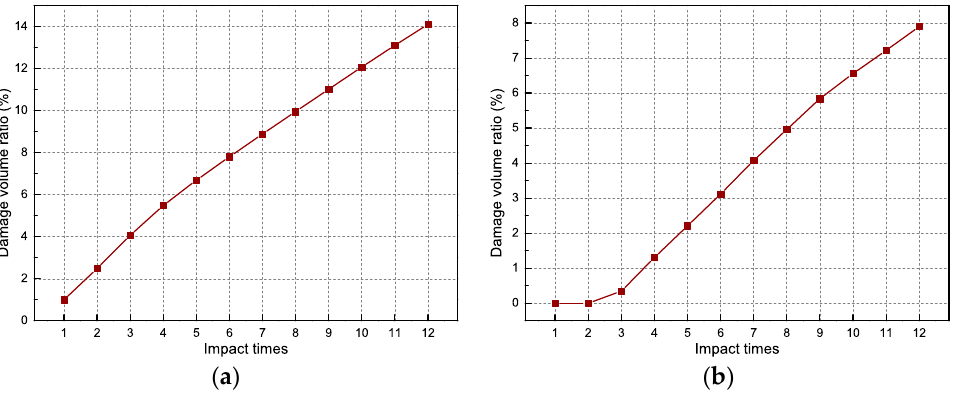
Figure 7. Damage volume ratio of concrete beam: ( a ) global damage ( d > 0); and ( b ) local damage ( d > 0.7).